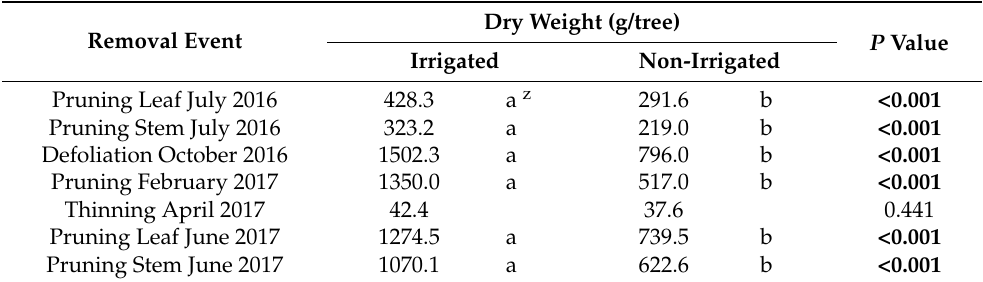
Table 5. Dry weight (DW) and N concentration in the different removal events for irrigated vs. non-irrigated for trees of “Julyprince” peaches in 2016, 2017, and 2018. Dry Weight (g/tree) Removal Event P Value